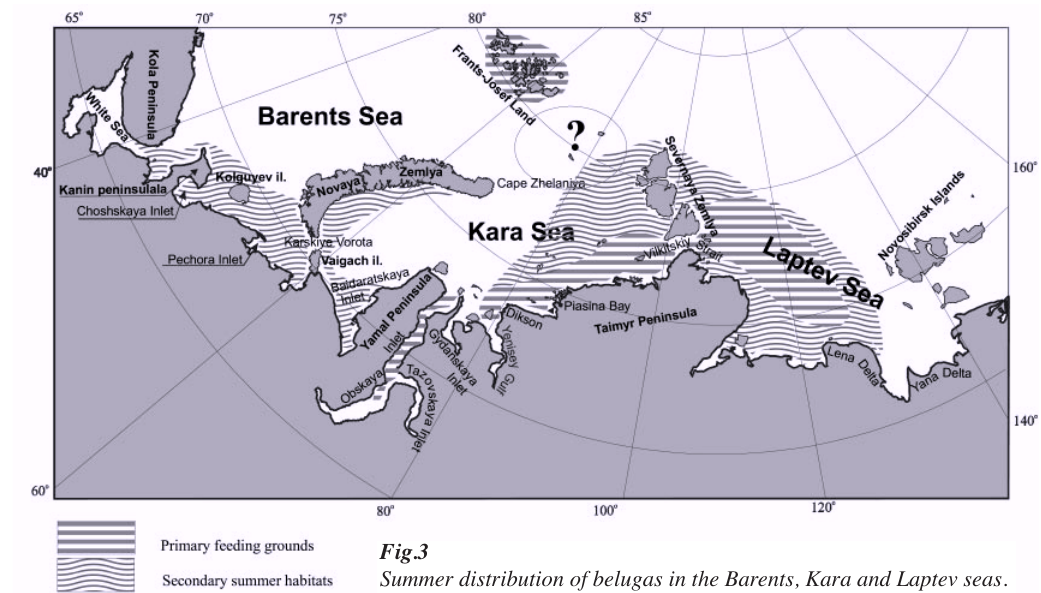
Fig.3 Summer distribution of belugas in the Barents, Kara and Laptev